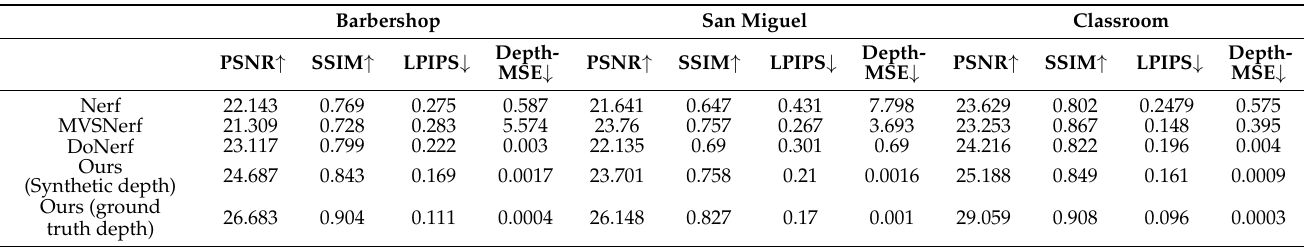
Table 1. Quantitative comparison of the test sets of the three datasets. We use three metrics: peak signal-to-noise ratio (PSNR) ( ↑ ), structural similarity (SSIM) ( ↑ ), and image perceptual similarity (LPIPS) ( ↓ ) to evaluate the rendering quality.